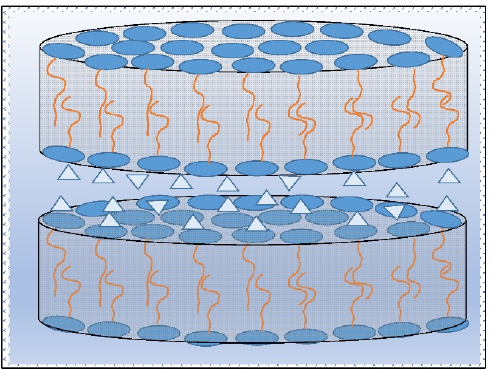
Figure 3. Schematic representation a formation of disc lamellar bilayers in water medium due to affecting the hydration intermediary forces. The symbols “ ∆ ” denominate water molecule O < H H .